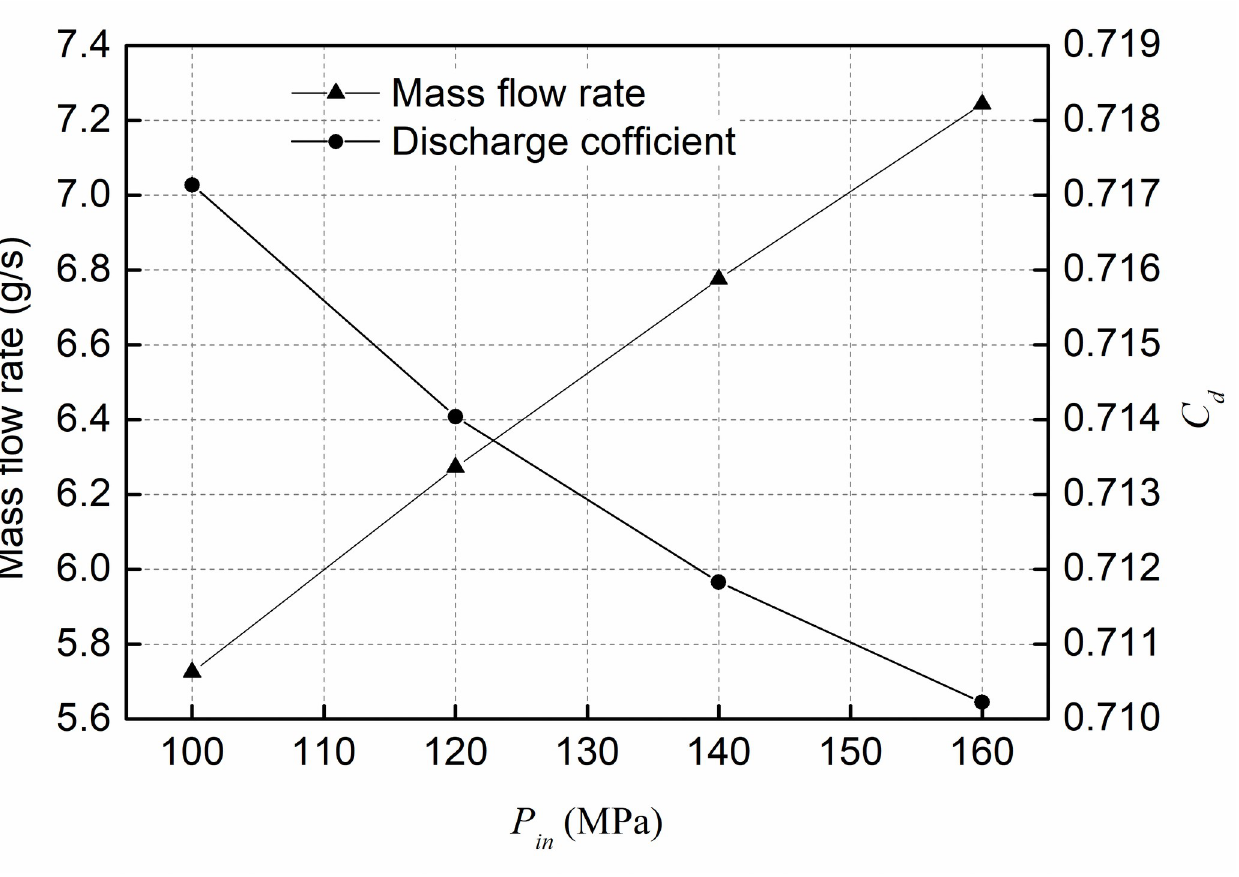
Fig 6. Mass flow rate and discharge coefficient at various P in and fixed P out of 5MPa.